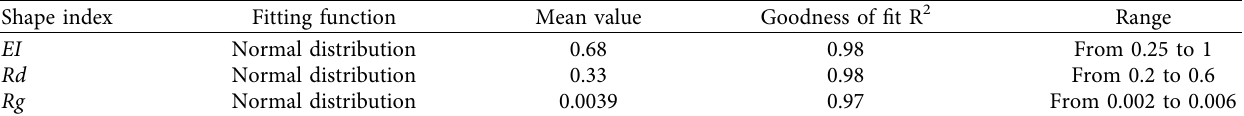
Table 1: Fitting function and related